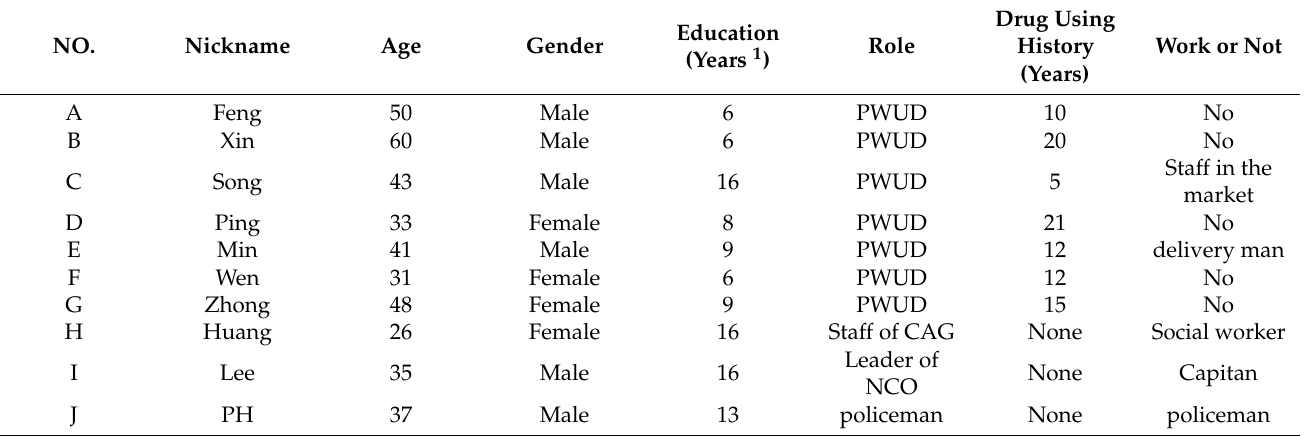
Table 1. Information of in-depth